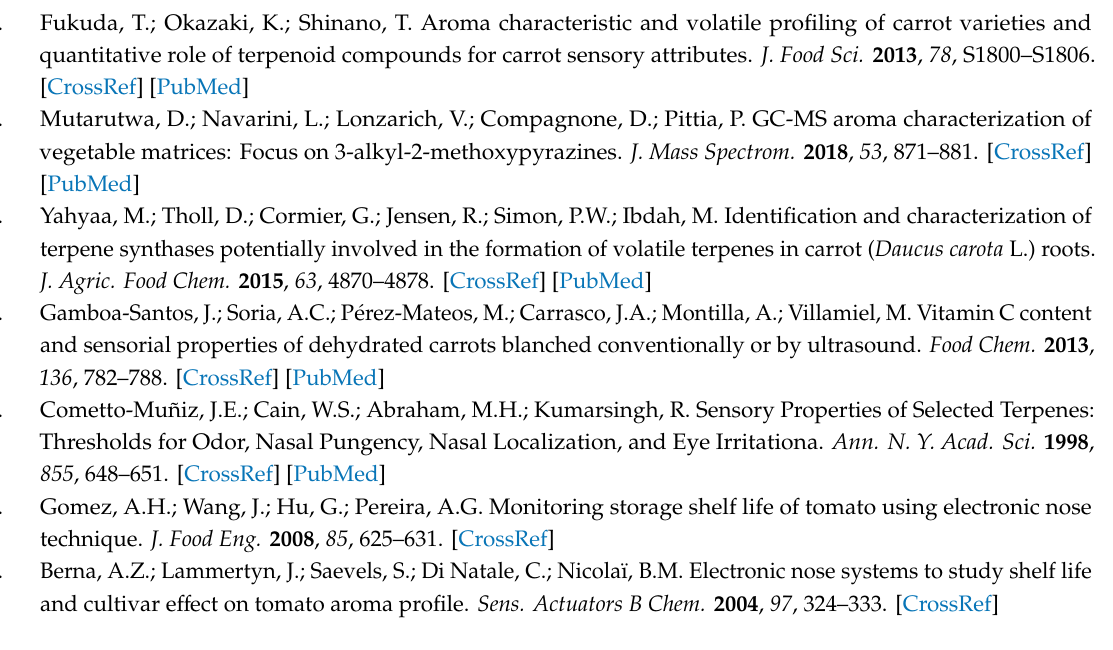
Figure S1: hpDNA-modified sensors array response vs. octanal after three months from start analysis. (A) Represented the measurements carried out at 25 ◦ C from the 1st day to the 8th day; (B) measurements carried out at 4 ◦ C from the 1st day to the 8th day. Table S1: Sequences of di ff erent loop size